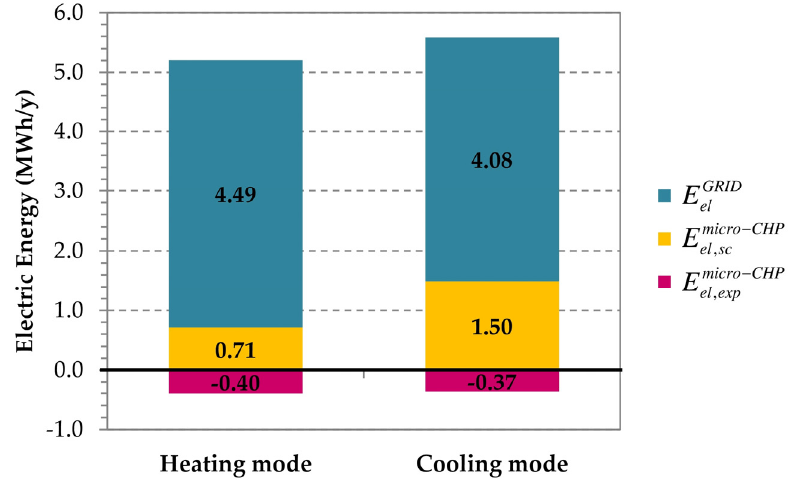
Figure 10. Electric energy flows.